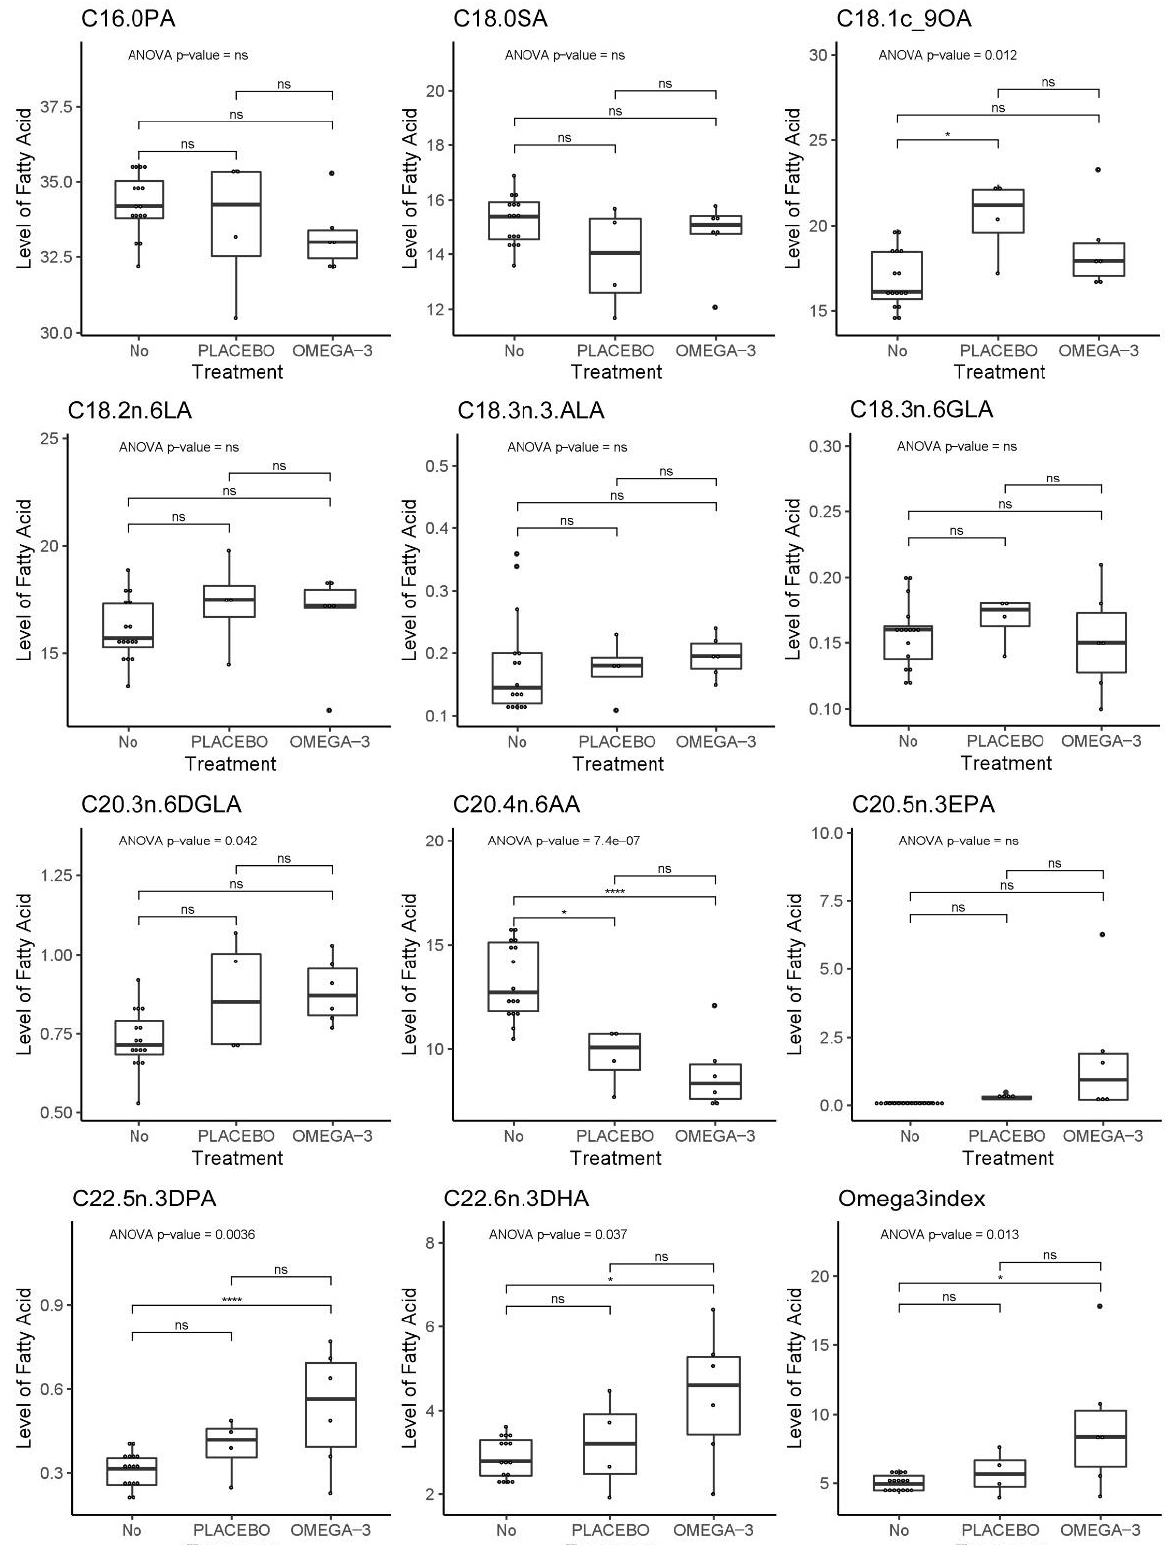
Figure 16. Mouse whole blood FA profiling and Omega-3 index. Stars indicate significant Tukey post hoc test. p -values indicate significance in the ANOVA model.